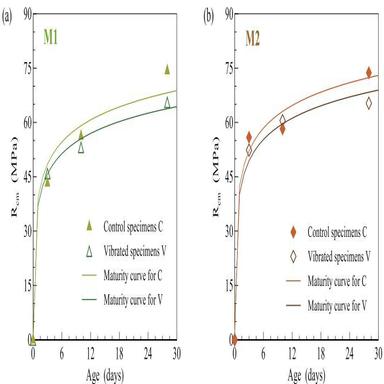
Mortar maturity curves: (a) M1 and (b) M2 mortar.